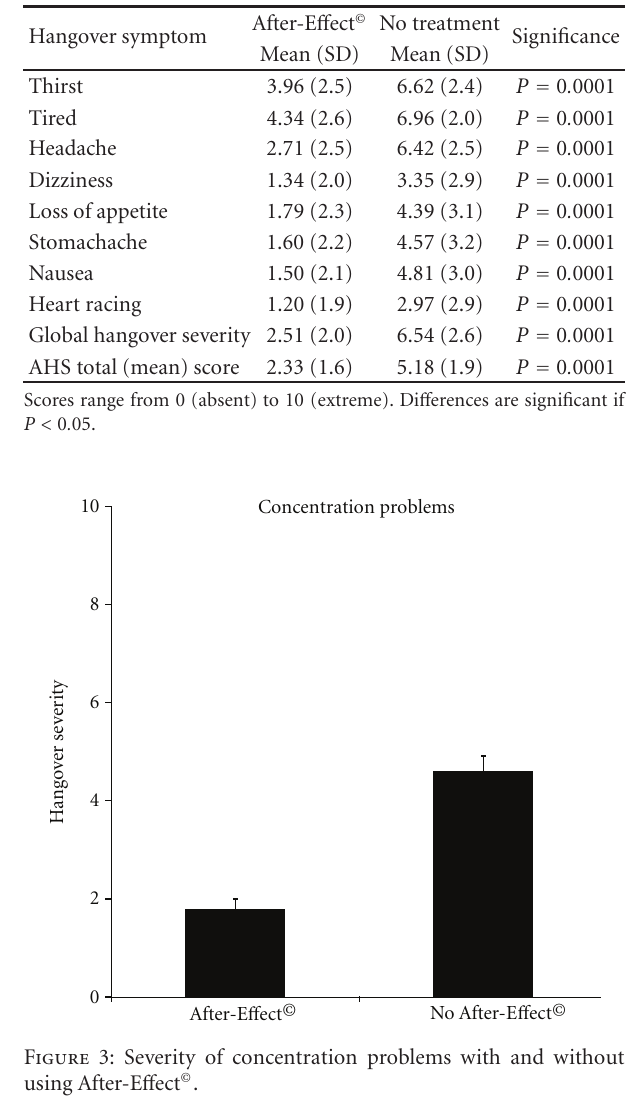
Table 2: Hangover symptom scores when treated with After- E ff ect © , and expected scores if After-E ff ect © had not been used ( N = 103).